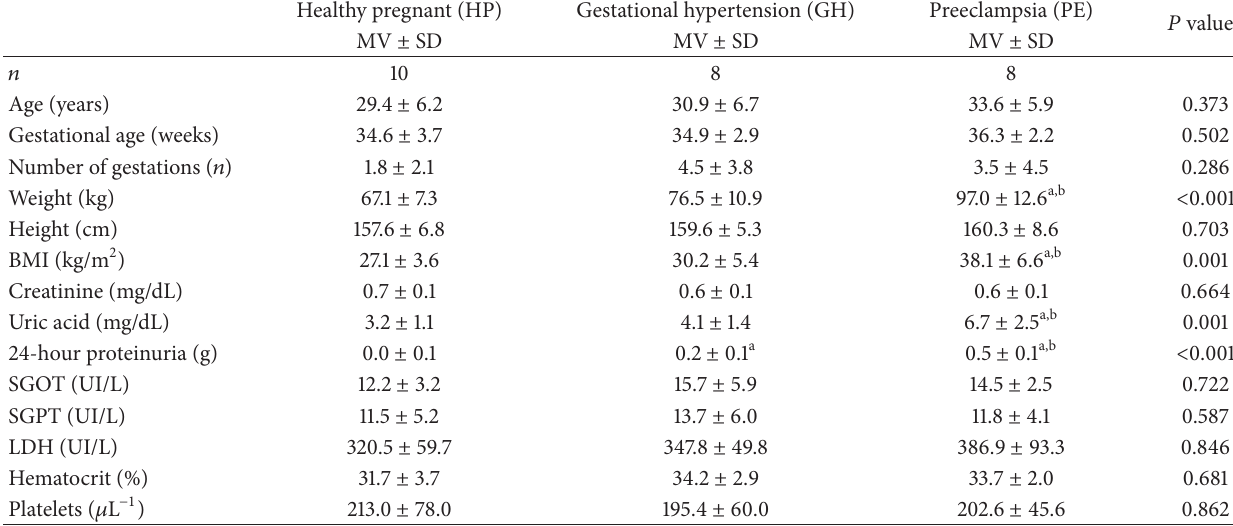
Table 1: Demographic and laboratory samples characteristics of the study populations according to pregnancy